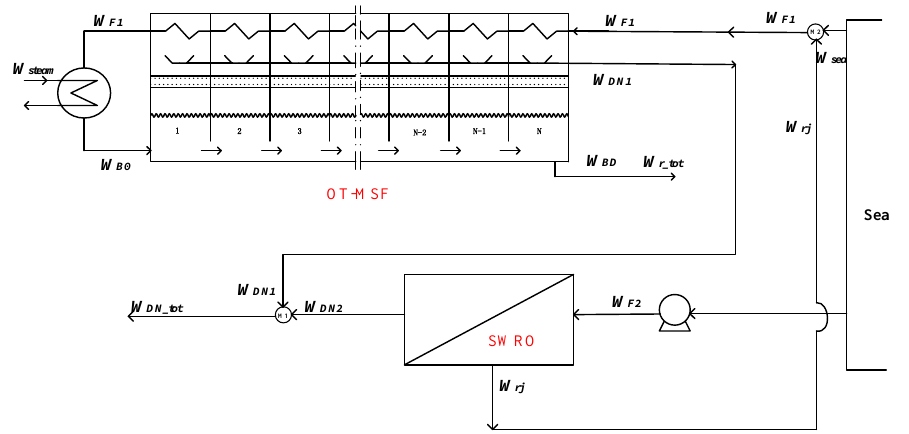
Figure 6. Option 6 — the rejected water of the SWRO system as part of the feed water of the OT-MSF Figure 6. Option 6—the rejected water of the SWRO system as part of the feed water of the OT- system. MSF